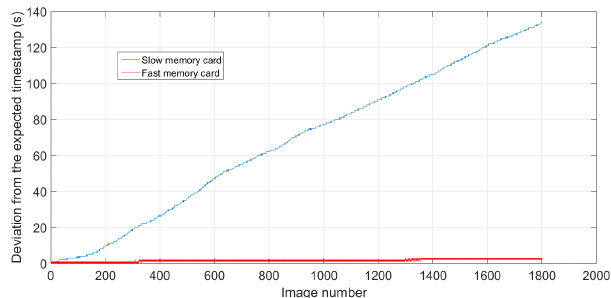
Figure 3. Differences between expected time stamps of pictures for a 30min period with a lapse time of 1s and the EXIF time stamp re- covered from the first 1800 images of a GoProH3+BE. Results are either for a relatively slow micro-SD card (64GB SanDisk Ultra microSDXC Class 10 UHS-I) or a fast card (32GB SanDisk Ex- trem Plus microSDHC UHS-I/U3). The fast card diverges by only 2s after 30min, while the slow card diverges by 134s at a visibly irregular